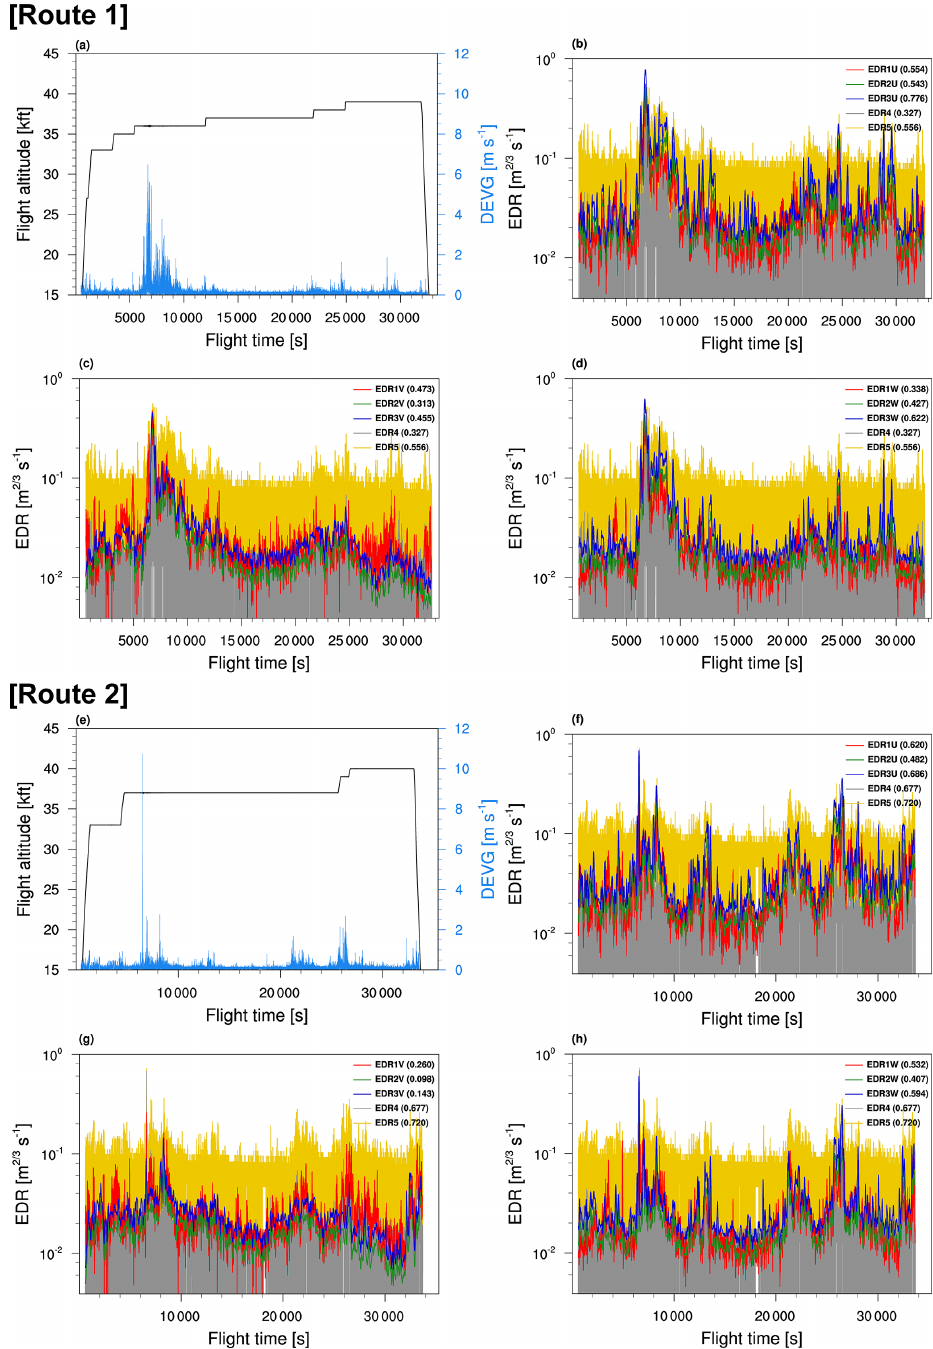
Figure 13. As in Fig. 11 but for (a–d) route 1 and (e–h) route 2 of the QAR data on 11 October 2012.